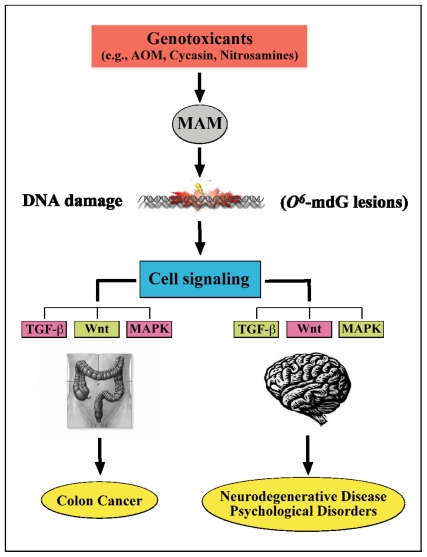
Proposed relationship between MAM-induced colon cancer and brain disease/disorders. Genotoxins, such as methylazoxymethanol (MAM), that induce O6-methyldeoxyguanine lesions (O6-mdG DNA damage), disturb cell signaling pathways, including transforming growth factor-β (TGF-β), wingless and proto-oncogene Int-1 (Wnt), and mitogen-activated protein kinase (MAPK). In general, the literature supports up-regulation (green) and down-regulation (pink) in association with the two distinct phenotypes. (Modified from Chen and Huang [112]). Thus, MAM may have opposing effects that depend on the mitotic state of the cell: whereas the agent may induce mutagenesis and proliferation (tumorgenesis) in cycling cells, in non-cycling cells (i.e., neurons) the outcome is cellular degeneration.